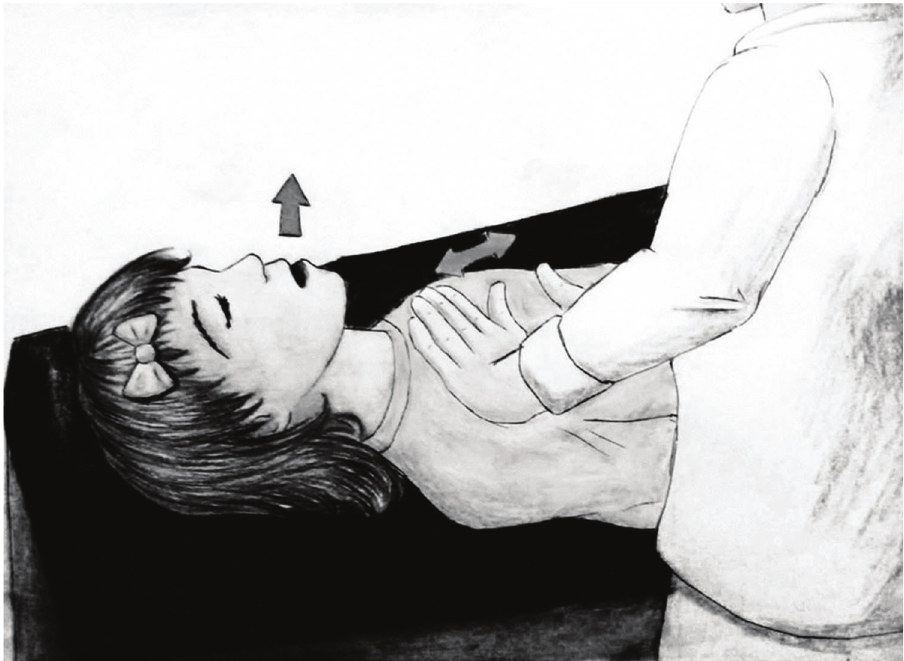
Figure 3 - Illustrative image demonstrating the forced expiration (huffing) technique associated with accelerated expiratory flow. The therapist places one hand on the patient ’ s manubrium and the other hand on the xiphoid process of the patient ’ s sternum. Thereafter, the therapist brings the two hands together during the patient ’ s exhalation, accelerating the outflow of air, while the patient simultaneously exhales with the glottis and mouth open, and the abdominal muscles